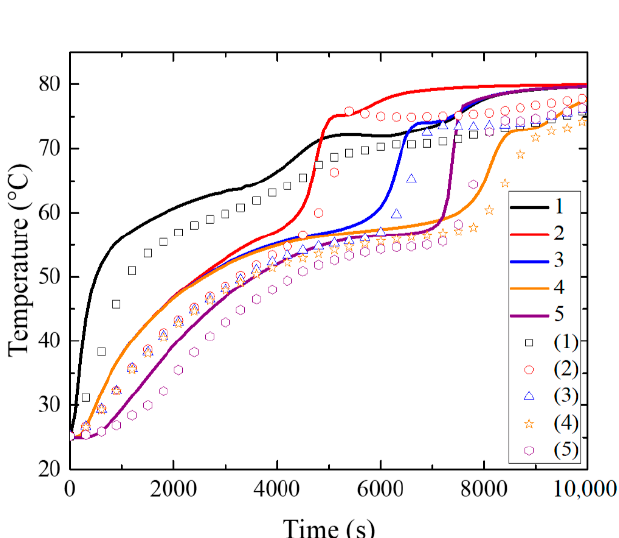
Figure 8. Comparison results for the case with 90° inclination angle between the numerical results (1–5) and the experimental data ((1)–(5)).